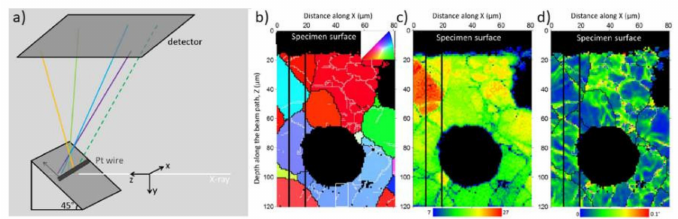
Figure 14. ( a ) Schematic illustration of the differential aperture X-ray microscopy (DAXM) approach. ( b ) Crystallographic orientation, ( c ) the number of indexed points, and ( d ) local misorientation map showing the microstructural details around a graphite nodule (black circular blocks) characterized using polychromatic DAXM. The colors in ( b ) represent the crystallographic orientation along the direction normal to the sample (see inset in ( b )). On the maps, cell walls of dislocations with misorientation angles in the range of 0.1–1 ◦ , 1–3 ◦ , and > 3 ◦ are shown as thin white lines, thin black lines, and thick black lines, respectively. The individual black pixels in the array away from the nodules are unindexed pixels [130,131]. Reprinted from